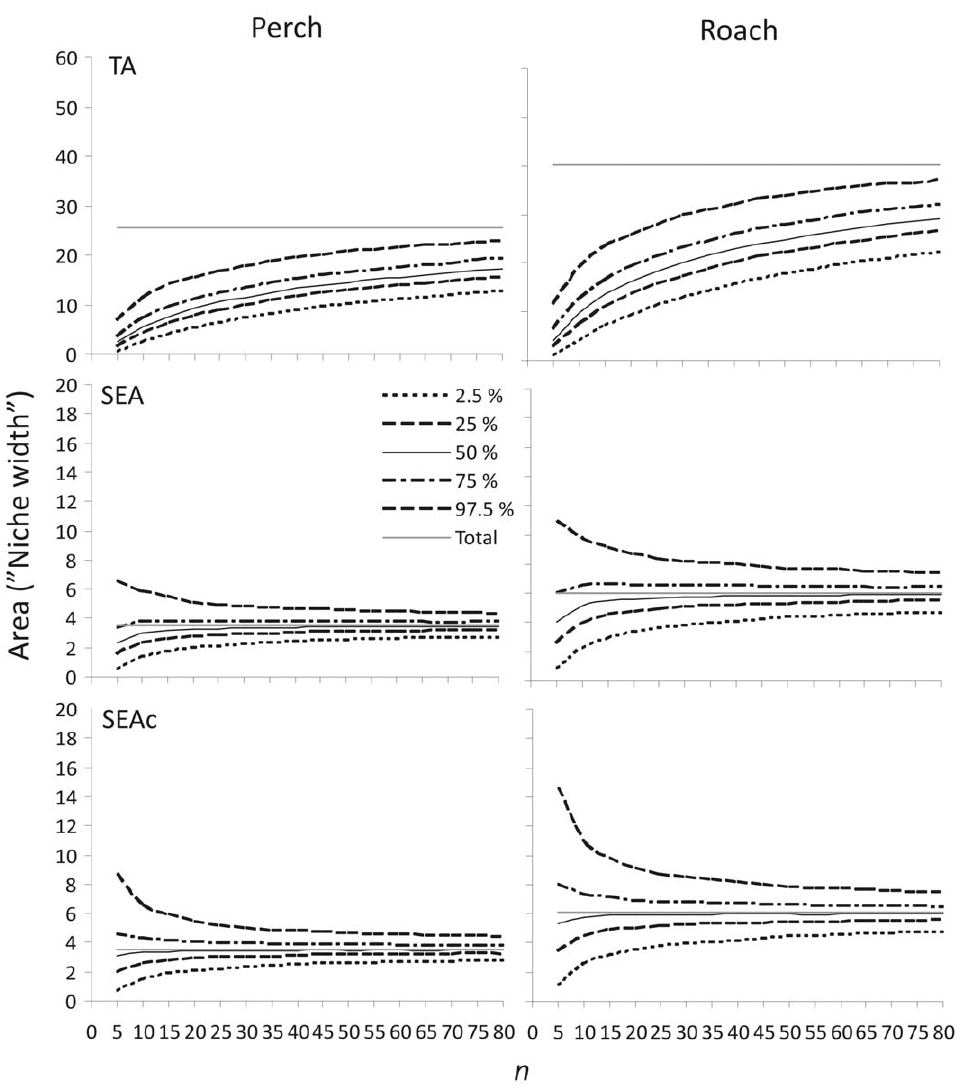
Figure 5. Isotopic niche widths calculated using simulated data. The data followed a multivariate normal distribution, but otherwise matched the empirical roach and perch isotope data with identical sample size, sample means and variance-covariance matrix. Lines represent the upper 97.5%, 75%, 50% and lower 25% and 2.5% percentiles for the niche area estimates after each 5000 resamplings with increasing sample size ( n + 5) from the simulated perch (left panel) and roach (right panel)